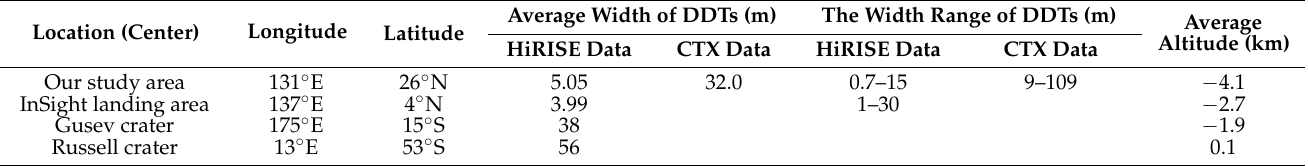
Table 3. Width range and average of DDTs.